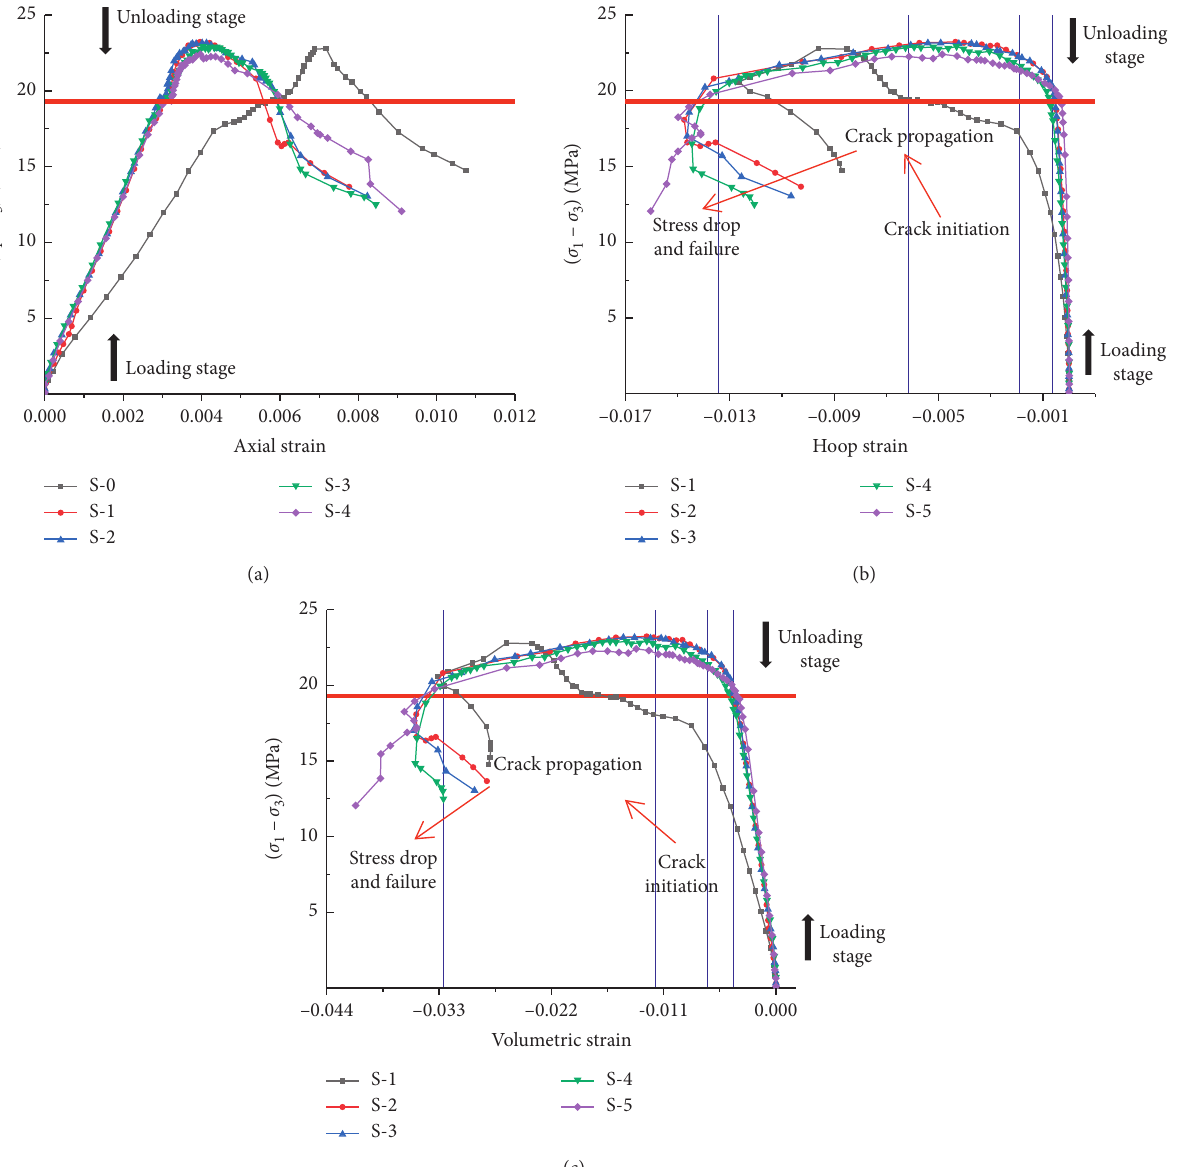
− σ ) with ε . (b) Variation of ( σ 1 3 1